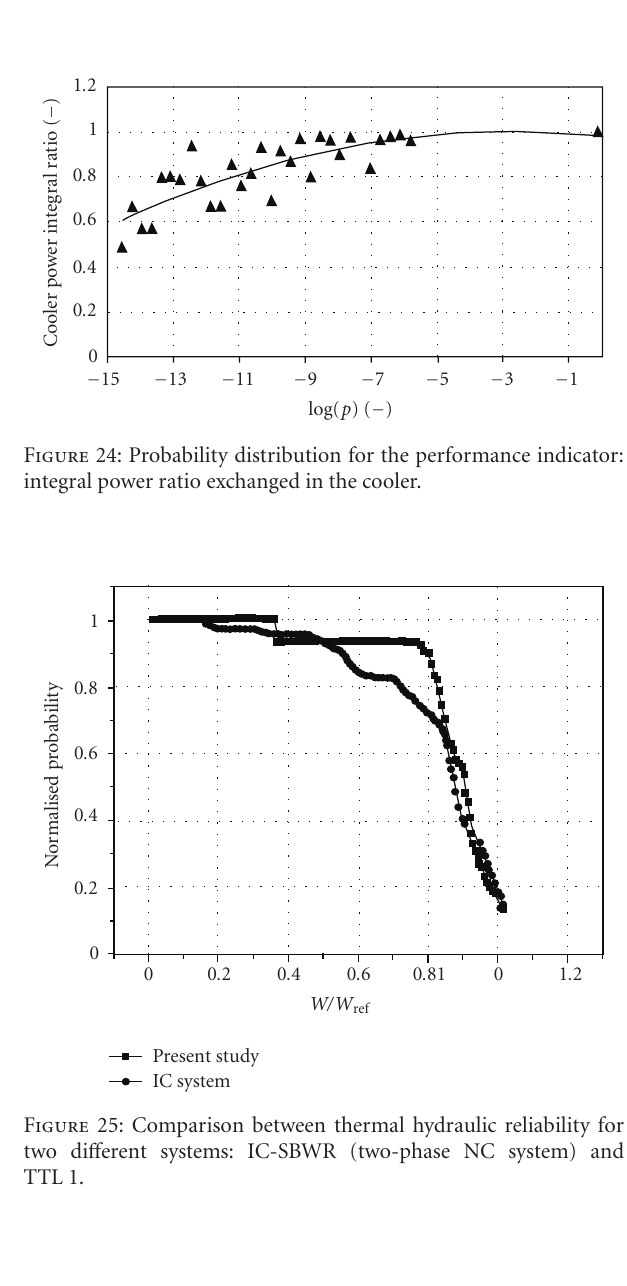
Figure 23: Time trends related to the ensemble of 137 code runs ([1–18] deterministic status): power exchanged in the cooler.